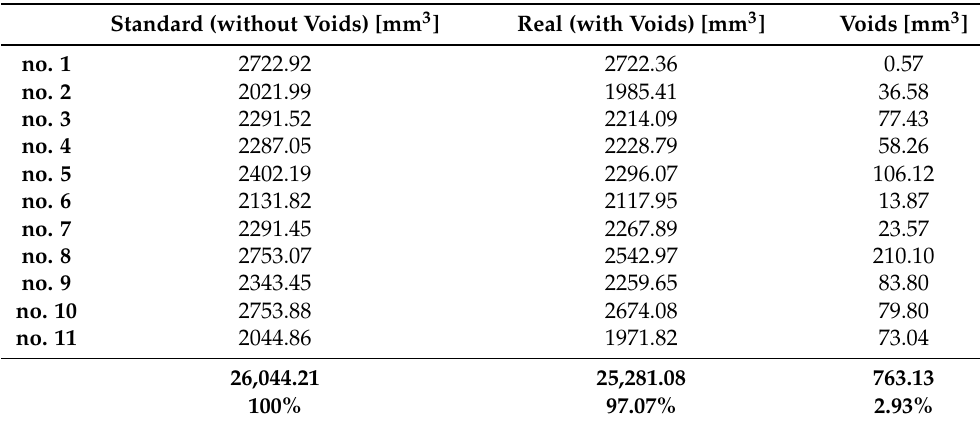
Table 3. The values of volume of each slice and internal voids for standard (without voids) and real models (with